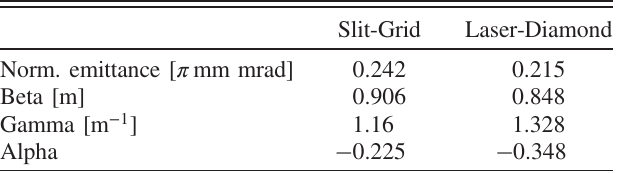
TABLE V. Comparison of normalized emittance and Twiss parameters obtained with both methods.